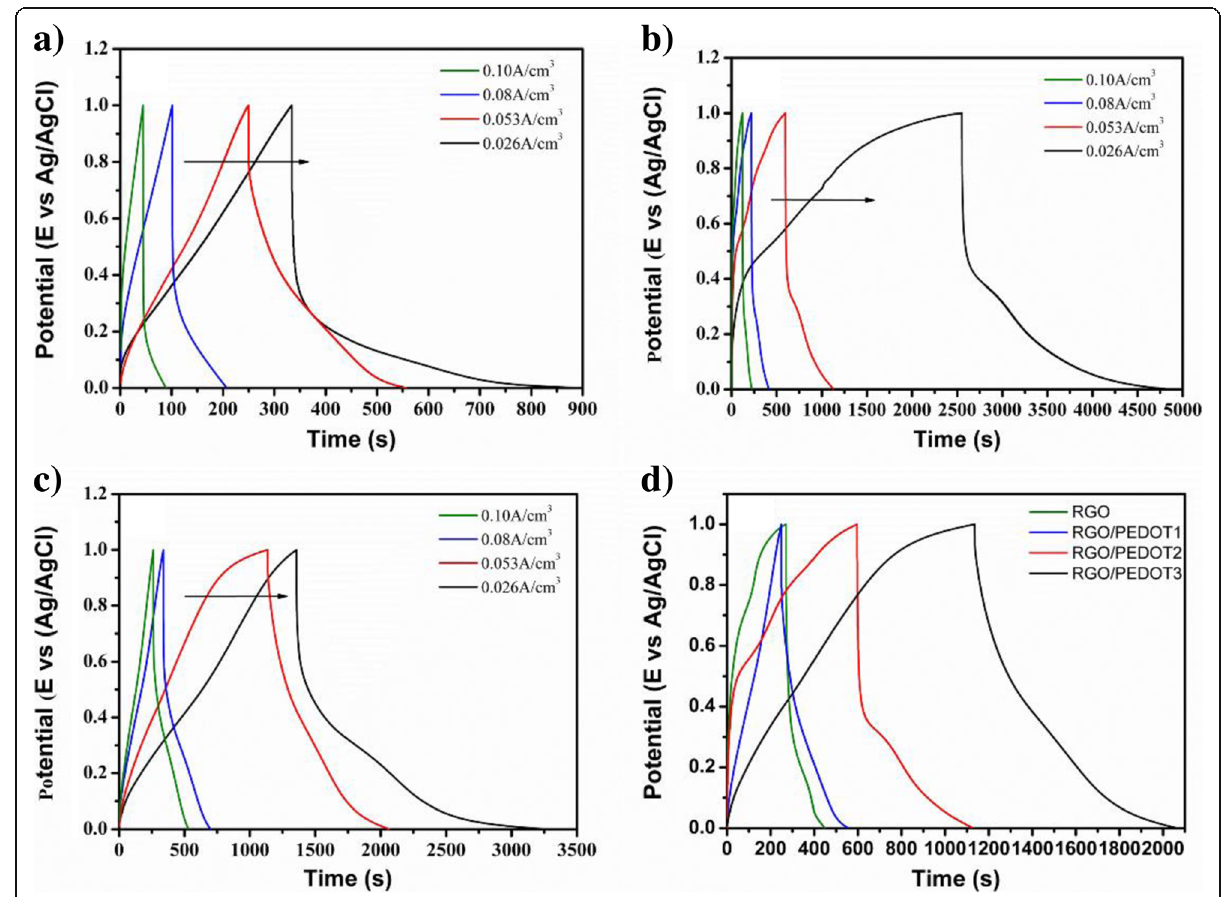
Fig. 8 GCD curves of a rGO, b rGO/PEDOT2, and c rGO/PEDOT3 with the increasing of scanning current density. d GCD curves of rGO and different rGO/PEDOT electrodes at a 0.053 A/cm 3 scanning current density